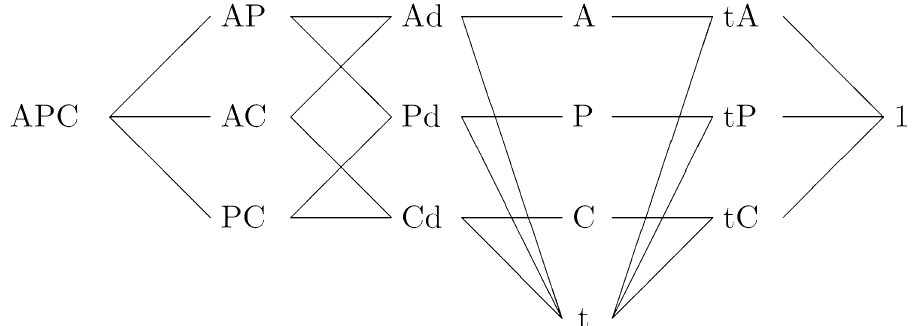
Figure 5. Diagram of the age-period-cohort model and its sub-models . The models are nested from right to left. APC age-period-cohort model, AC age-cohort model, AP age-period model, Ad age-drift model, PC period- cohort model, Pd period-drift model, Cd cohort-drift model, A age model, P period model, C cohort model, A age model, t trend model, At age-trend model, Pt period-trend model, Ct cohort trend model, 1 : intercept model. The term drift means that there must be some temporal variation in rates that cannot be interpreted as the effect of other non-specified parameters in the